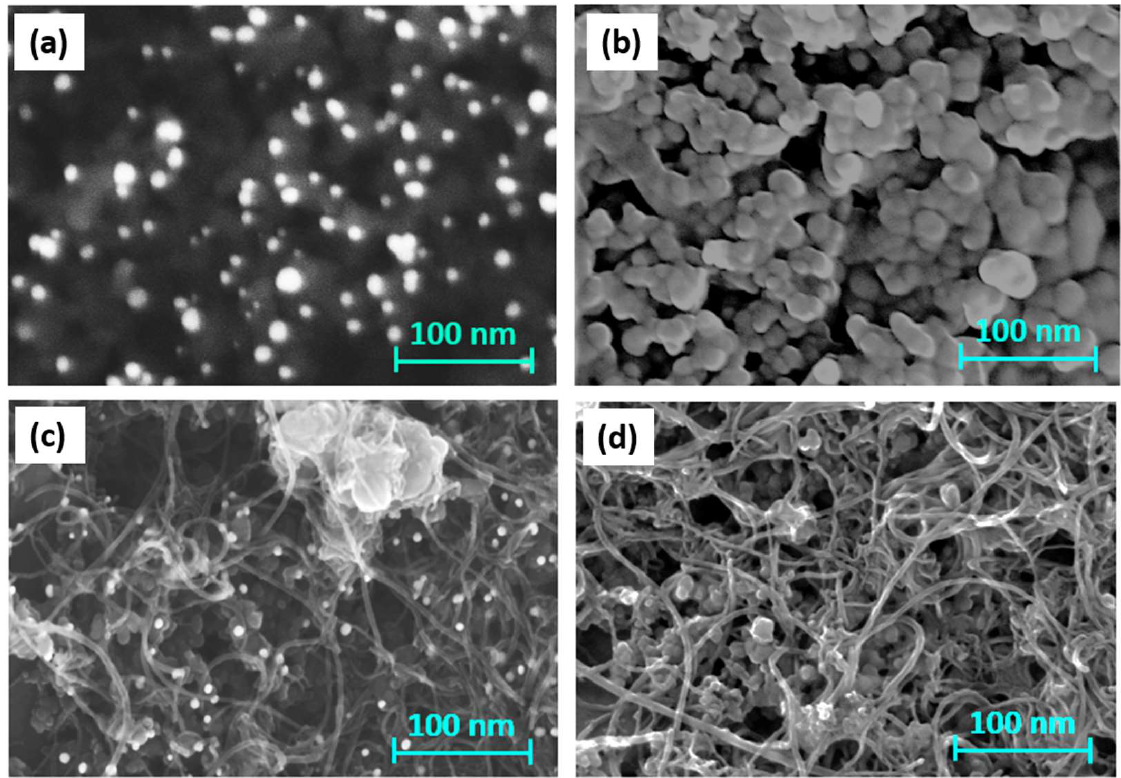
Figure 2. SEM images of screen-printed electrodes before and after modification with CNTs: ( a ) bare SPAuNPE; ( b ) bare SPCE; ( c ) SPAuNPE/CNT; and ( d ) SPCE/CNT. Table 1. Optimization of the variables in the fabrication of the aptasensor.